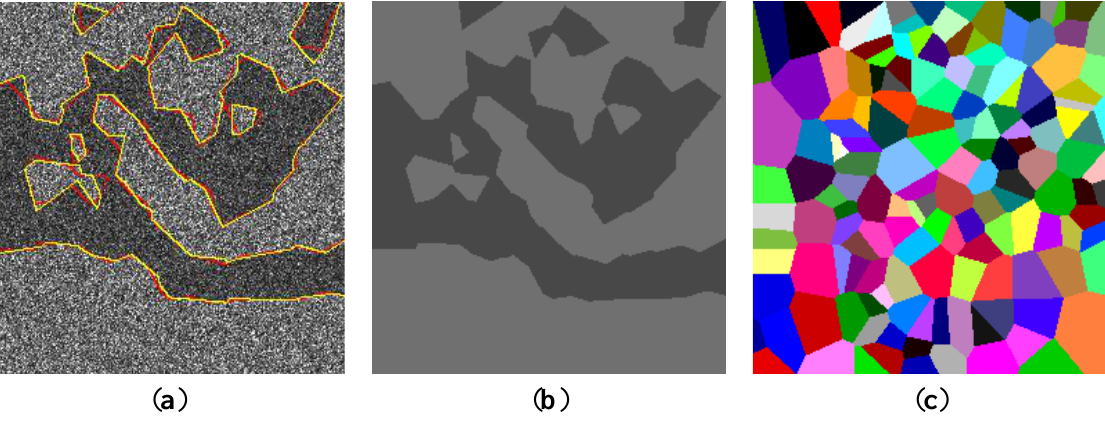
Figure 5. Results of ( a ) final partition of image domain; ( b ) optimal segmentation after 4,000 iterations and Outlines of the real regions (yellow) and segmented regions (red) overlaid on the simulated